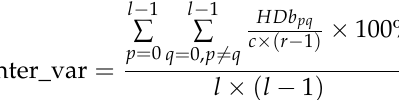
Figure 12. Reliability of responses.